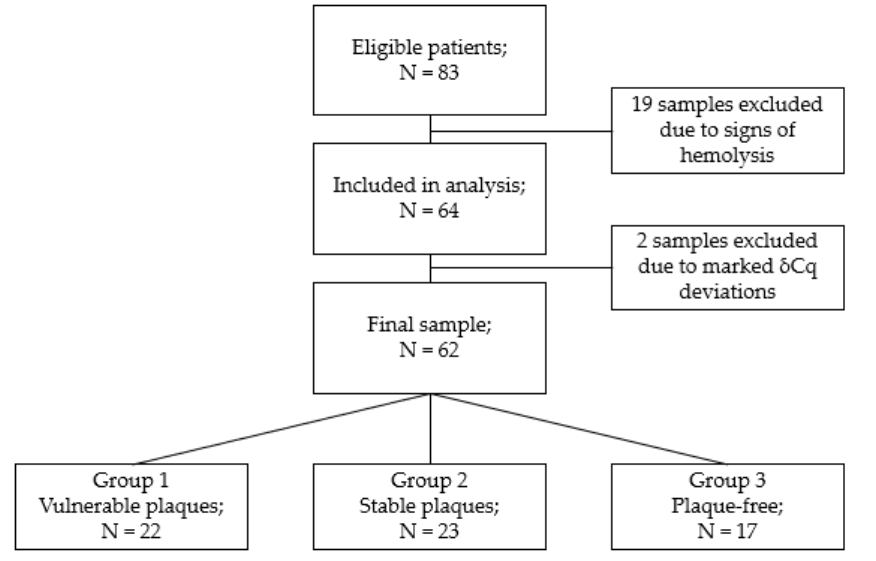
Figure 1. Block diagram of the study.